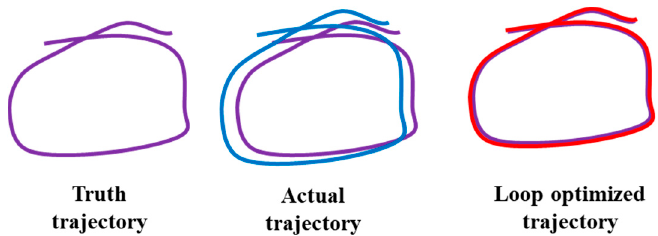
Figure 3. Schematic diagram of the loop optimization process.